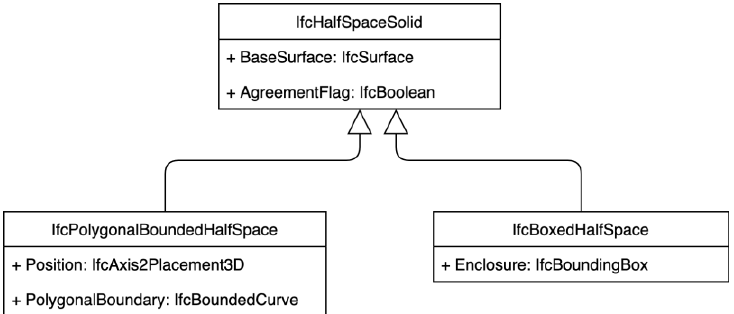
Figure 4. Unified modeling language (UML) for IfcHalfSpaceSolid , IfcPolygonalBoundedHalfSpace , and IfcBoxedHalfSpace [40].